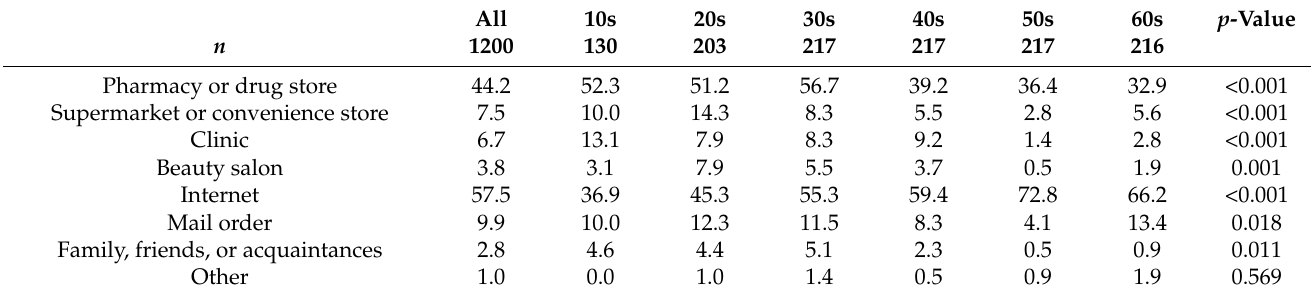
Table 12. Ways of obtaining estrogen-like supplements.